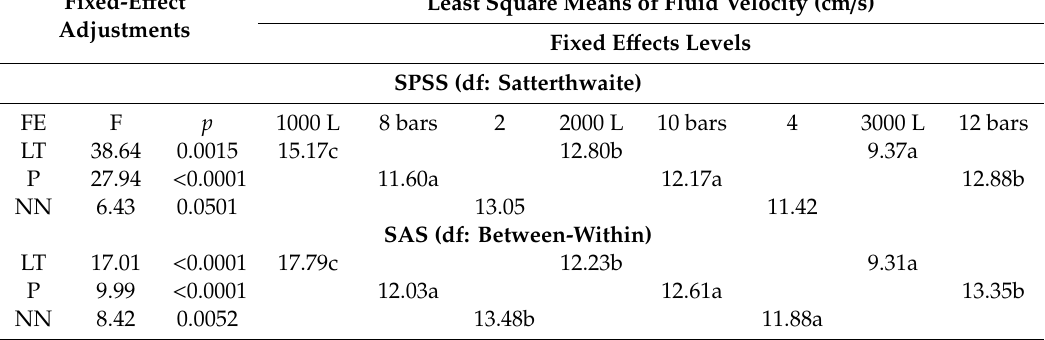
Table 8. Contrast statistic (F) and p-value for each fixed e ff ect (FE): Liquid level in the Tank-L, Pressure-bar, and Number of active Nozzles. Estimated averages of fluid velocity for the di ff erent levels of the FE. df: degrees of freedom. Di ff erent letters show significant di ff erences after Tukey’s test ( p < 0.05).